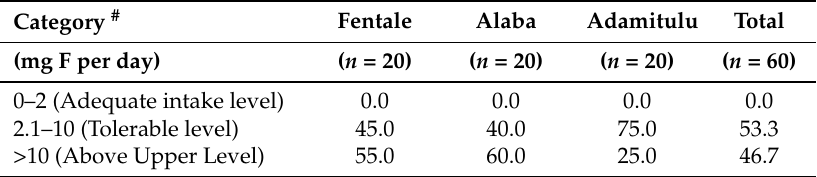
Table 2. Prevalence (%) of daily dietary F intake of children according to IOM classifications for evaluation of F intake levels.